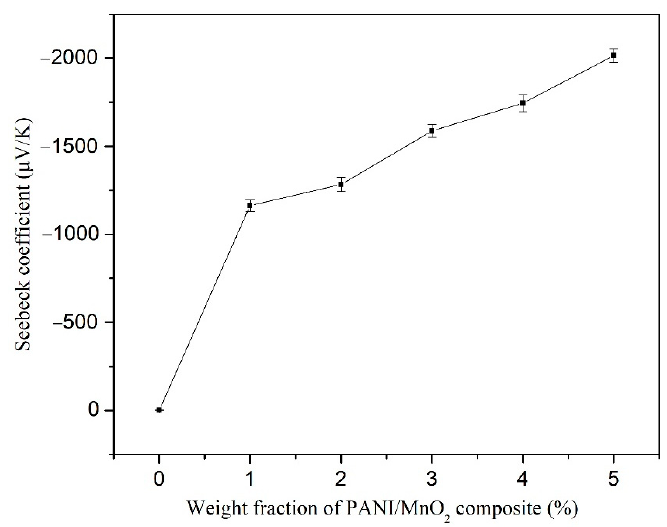
Figure 9. Seebeck coefficient of the cement-matrix composites containing different dosages of PANI/MnO 2 composite.